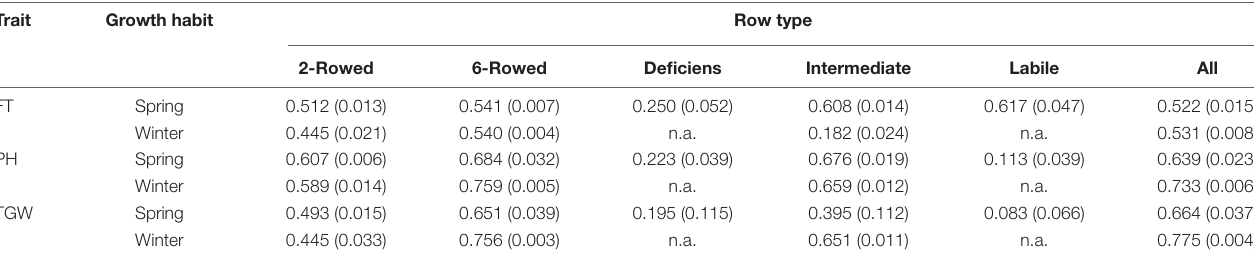
TABLE 6 | The prediction ability of flowering time (FT), plant height (PH), and thousand grain weight (TGW) using the accessions in the core collection as training set and the remaining phenotyped accessions as test set. Trait Growth